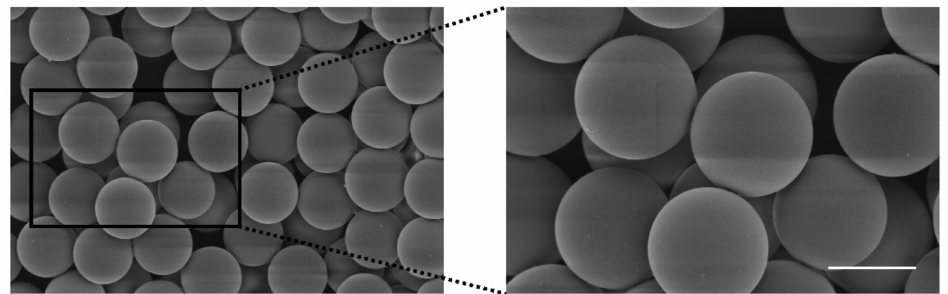
Figure 4. The SEM of SPRC@PLA microspheres (scale bar = 20 µ